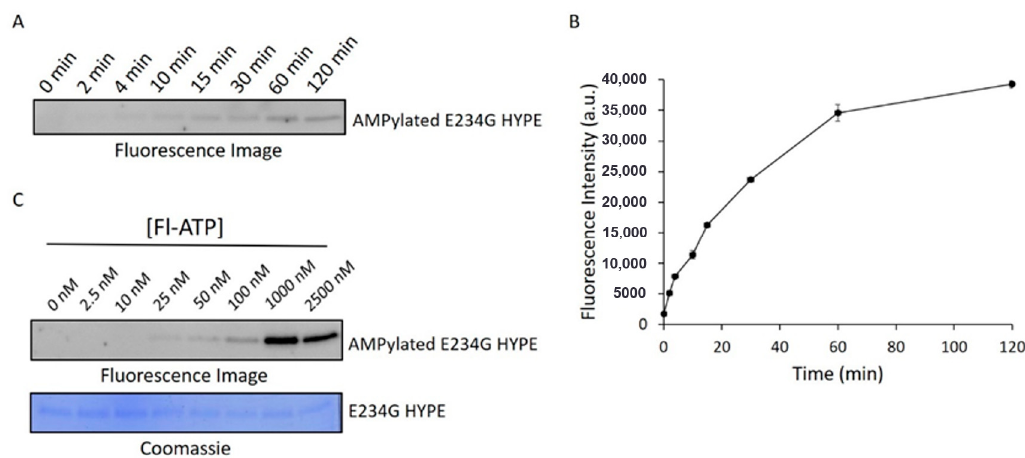
Figure 3. Assessment of AMPylation kinetic parameters. ( A ) Representative fluorescence image of ∆ 102 E234G HYPE autoAMPylation time-course. ( B ) Quantification of two independent experiments as in ( A ). Data represented as the mean +/ − SEM. ( C ) Fluorescence image (top) of ∆ 102 E234G HYPE autoAMPylation at various Fl-ATP concentrations and corresponding Coomassie image (bottom).